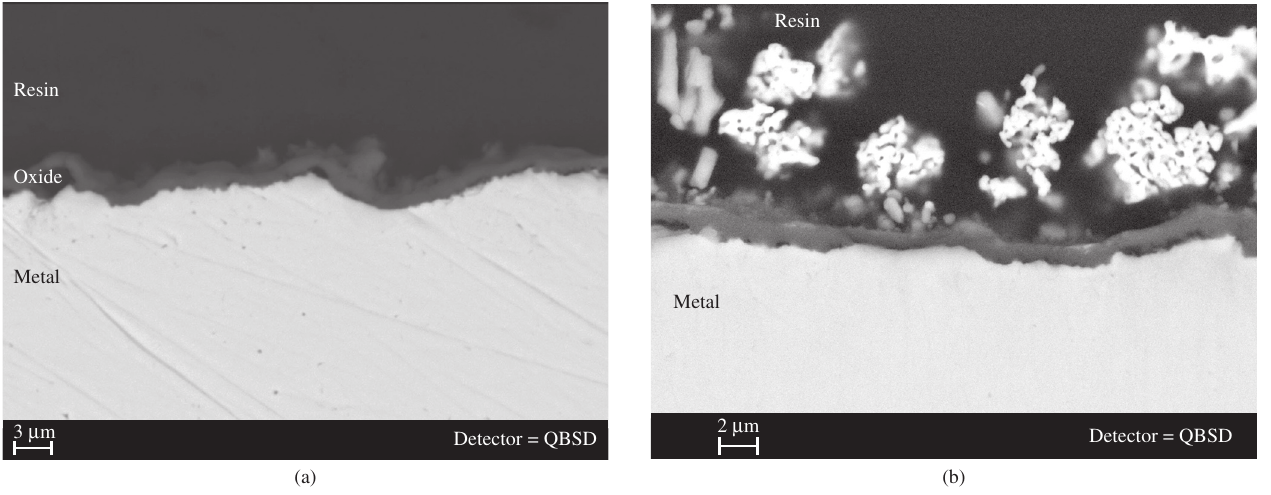
Figure 4. Cross section of Fe-20Cr-4Al oxidized for 200 hours at 1000 °C. a) Uncoated; and b) LaCrO